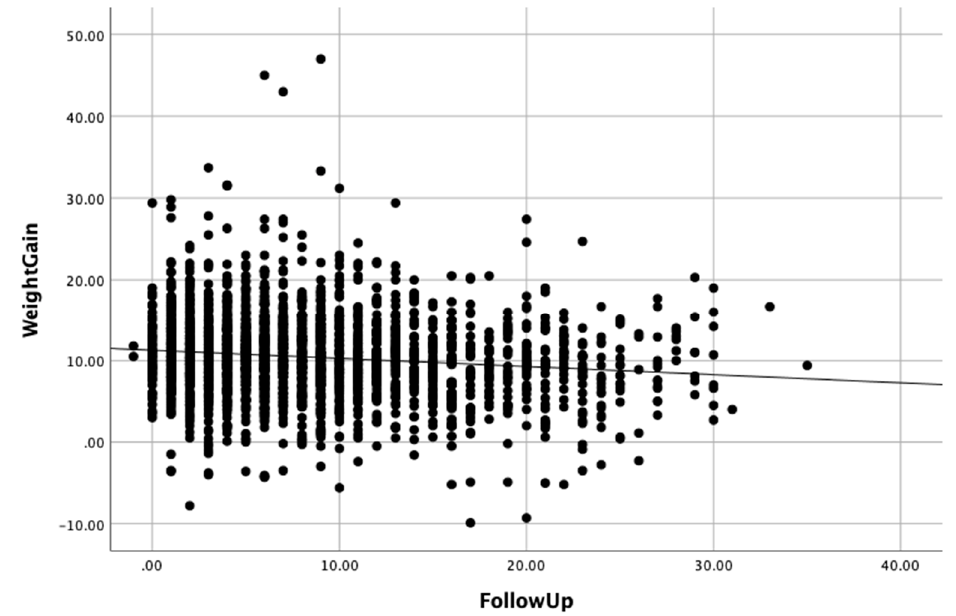
Figure A1. Scatterplot of gestational weight gain (in kg) vs. length of follow-up (in weeks).